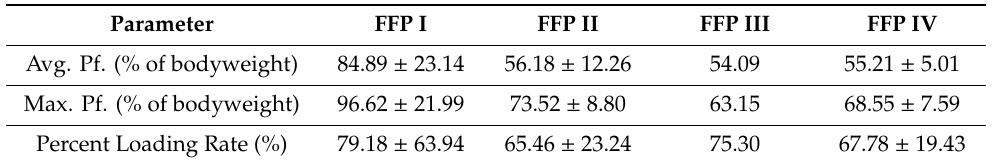
Table 4. Overall gait